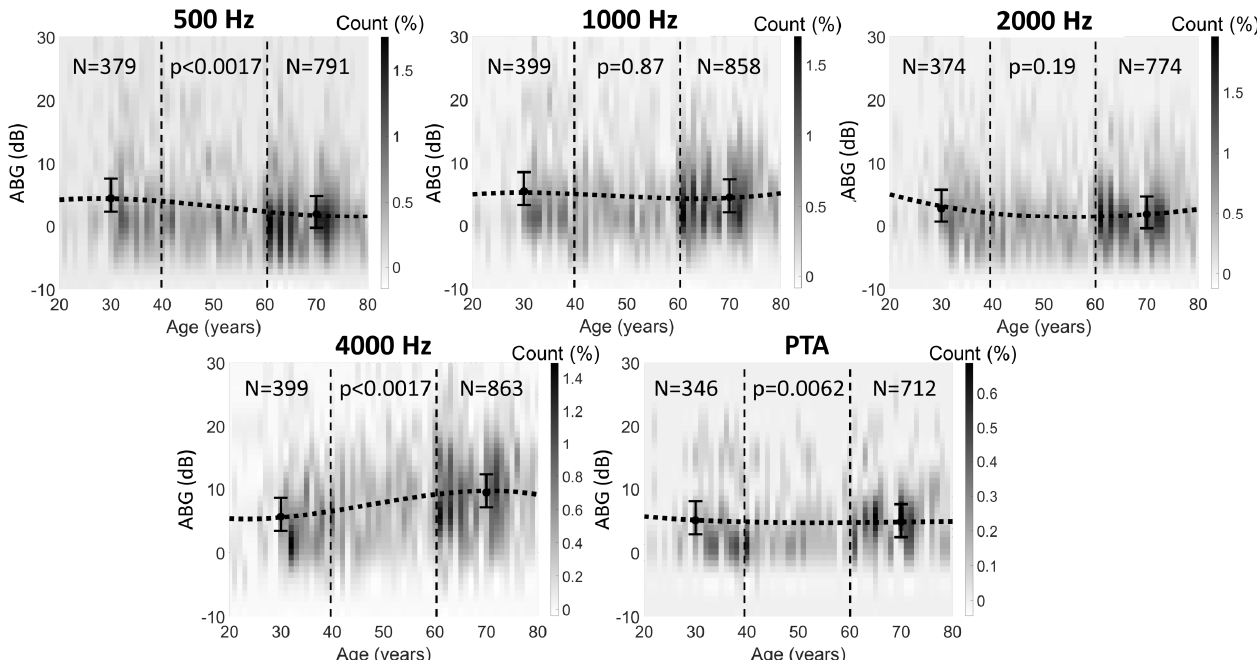
Figure 5. Air-bone gap (ABG) distribution with age and frequency. Error bars indicate the mean ABG and 99% confidence interval for two age groups: young (20–40 years) and old (60–80 years). The colours indicate the two-dimensional histogram (1-year and 1-dB-ABG bin size) of the data, relative to both ABG and age. Colour bars indicate the frequency of occurrence in units of percent relative to the total number of tested ears. The dotted lines correspond to a 3rd-degree spline fitted to the data point cloud, used only for illustrating the trend in the data. Vertical dashed lines provide a visual separation of the data corresponding to the younger and older age groups.